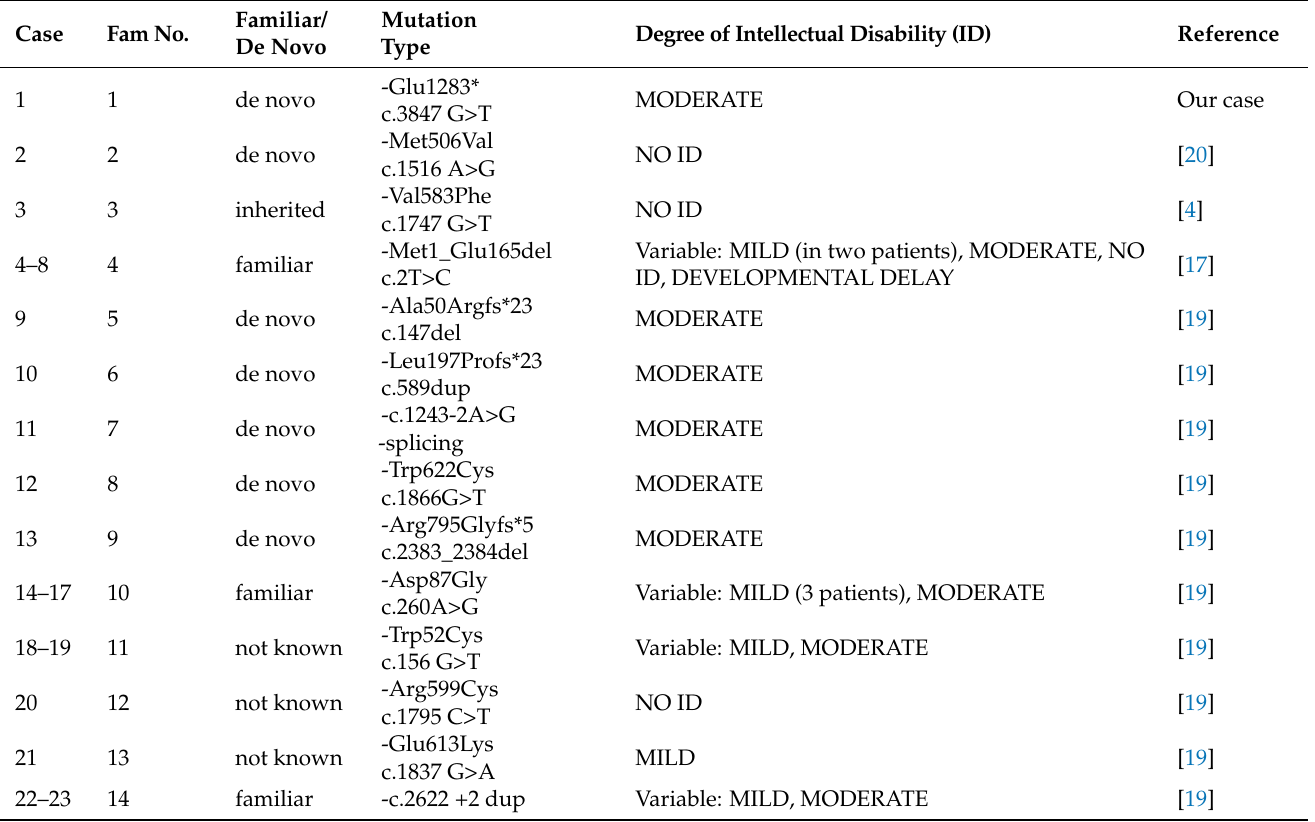
Table 2. Correlation between mutation types and degree of intellectual disability in 23 females carrying pathogenic KDM5C